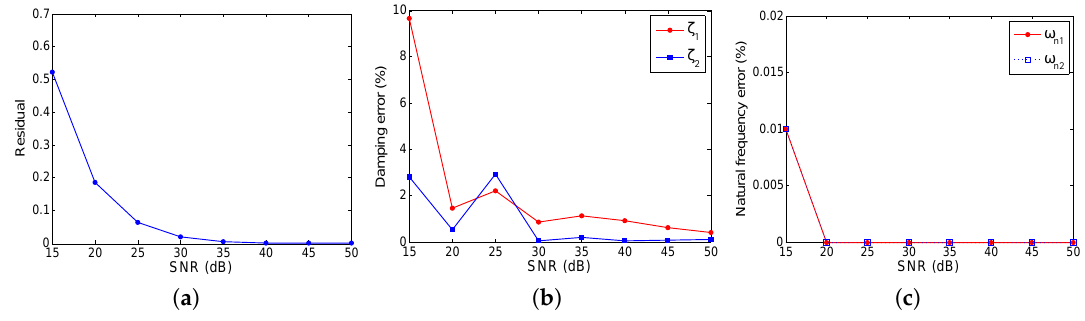
Figure 14. Effect of noise on the fitting residual, damping ratio and natural frequency for EO = 5, ζ 1,2 = 0.002 and SD = 0.10, ( a ) fitting residual, ( b ) error in damping ratio, ( c ) error in natural